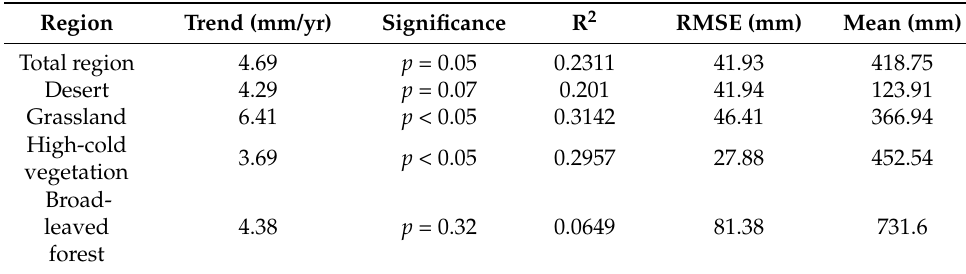
Table 4. Trend analysis and mean value of temperature on each region.